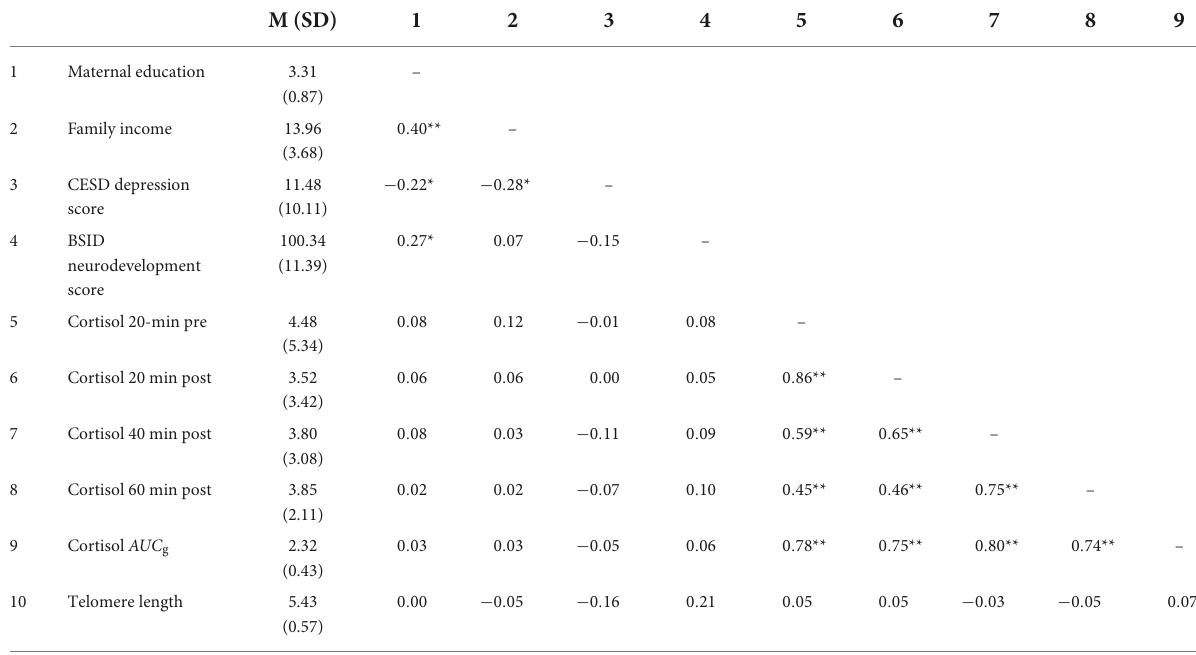
TABLE 2 Descriptive statistics and correlations among variables.